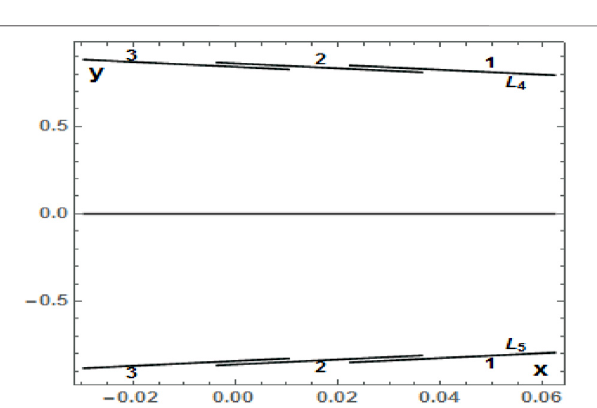
FIGURE 14 | Positions of the two triangular equilibrium points L 4 and L 5 on the xy – plane as a function of σ 1 ′ , which varies in the interval (0.01, 0.06) for ′ equal to 0.02 (1), 0.04 (2), and 0.06 (3). The radiation fi xed values of σ 2 pressure, oblateness, mass of the disc, and triaxiality parameters of the bigger primary are kept as constants as in the previous case (Table 11) .